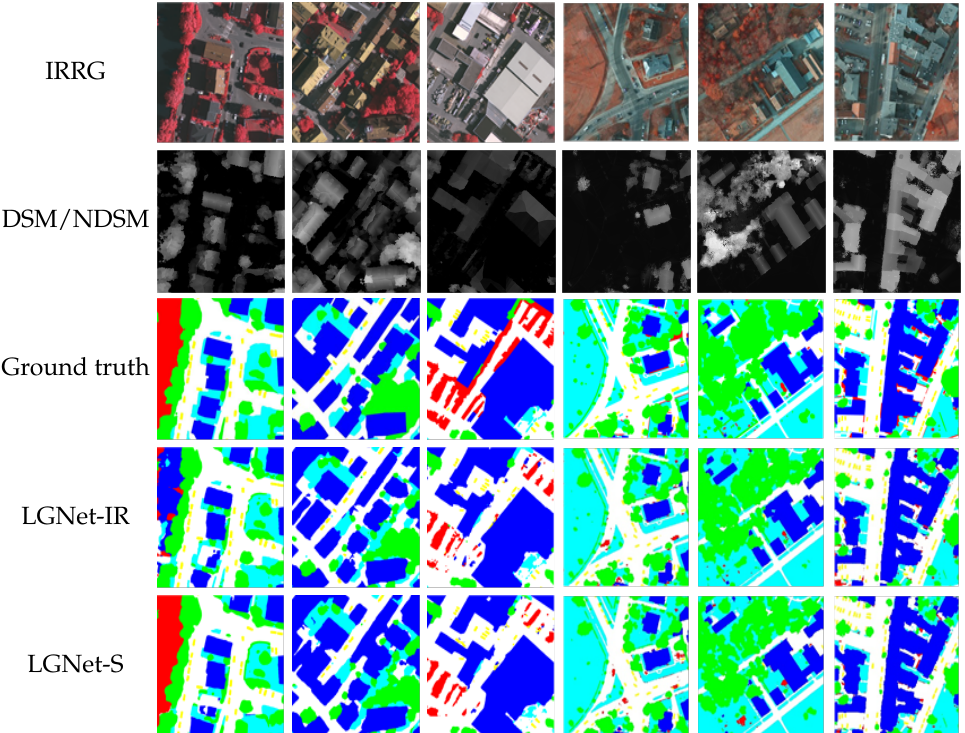
Figure 6. Some samples of the LGNet-IR and LGNet-S results on the ISPRS Vaihingen and Potsdam